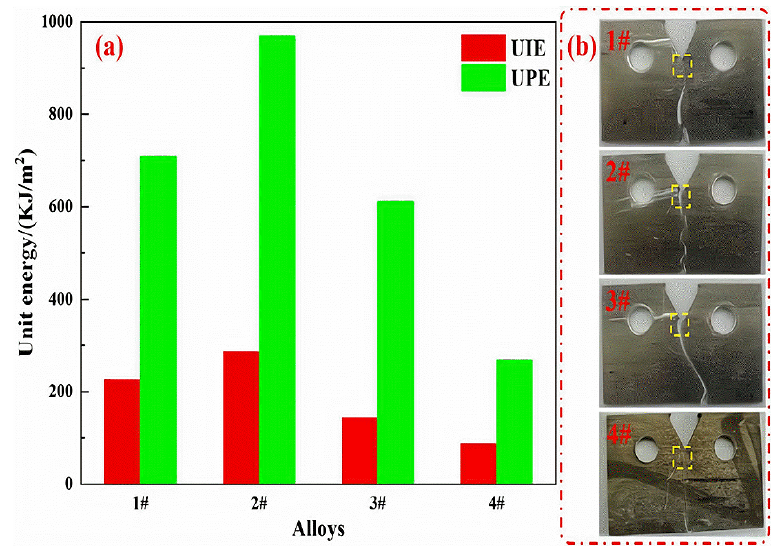
Figure 9. Tear test results of Al-5Mg-3Zn based alloys (1#, 2#, 3# and 4# indicate Ag content of 0, 0.2, 0.4 and 0.6 wt%) ( a ) UIE (unit initiation energy) and UPE (unit propagation energy) results, ( b ) tear samples’ macroscopy [41].